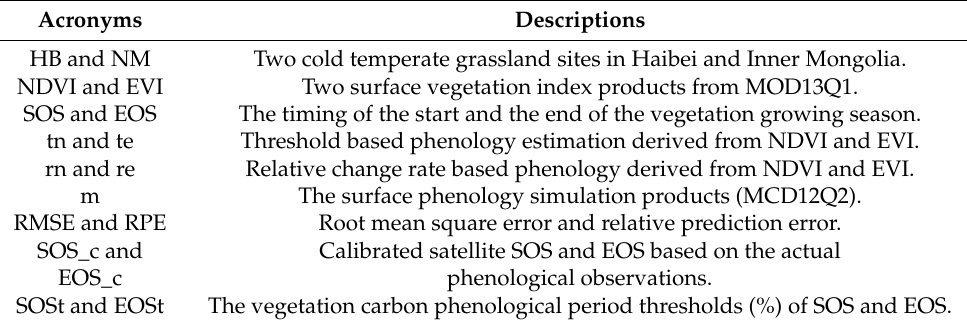
Figure 2. Examples of different methods for calculating vegetation phenology in Haibei (HB) and Inner Mongolia (NM) grassland stations (2004). The phenological period of vegetation in HB ( a – d ) and NM ( e – h ) are estimated by threshold method (left column) and relative change rate method (right column). For the threshold method, three filters, including asymmetric Gaussian function (GS), double logistic curve (LG), and Savitzky–Golay (SG) filtering, are used to fit and reconstruct the smoothing continuous time series of normalized difference vegetation index (NDVI) and enhanced vegetation index (EVI). The green and yellow lines represent the start time (SOS) and end time (EOS) of the growing period for the year, respectively. Table 1. Acronyms and their descriptions in this study.